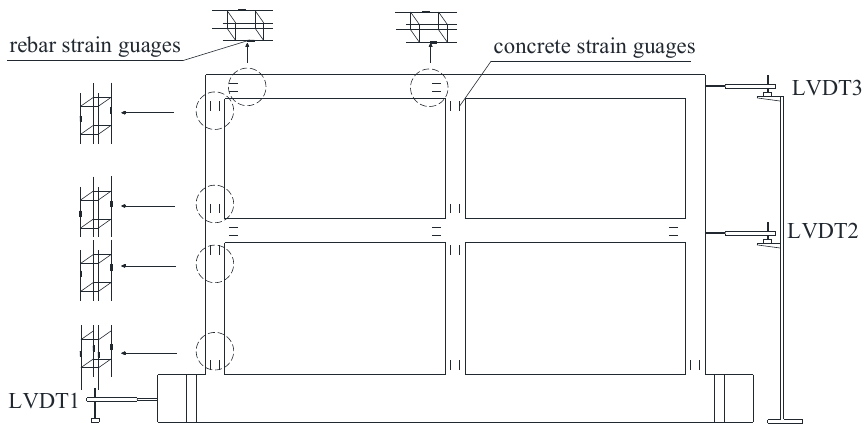
Figure 5. Loading protocol.